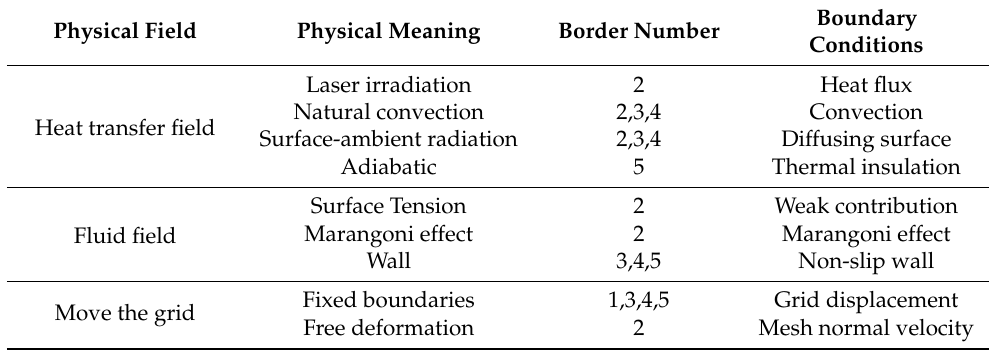
Table 2. Boundary condition settings.